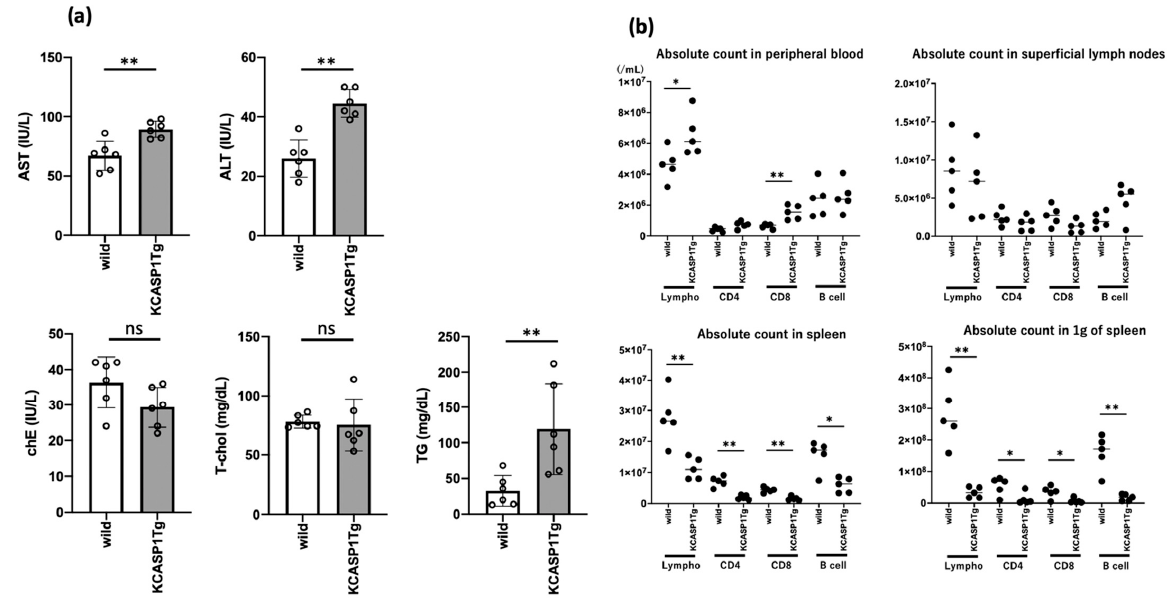
Figure 3. KCASP1Tg mice showed elevated serum liver transaminase and neutral fat level and insufficient production of lymphocytes. Plasma biochemical analysis and lymphocyte count in both 16-week-old KCASP1Tg and WT mice were performed (n = 6 per group). ( a ) The concentration of serum liver transaminase, neutral fat levels were elevated in KCASP1Tg mice with significance ( p values; AST, 0.0087; ALT, 0.0022; TG, 0.0087, respectively). ( b ) Peripheral blood lymphocyte count was elevated in KCASP1Tg mice compared to WT ( p = 0.0317). The amounts of CD8 were also increased in KCASP1Tg mice ( p = 0.0079). In superficial lymph nodes, the absolute number of lymphocytes, CD4 T cell, CD8 T cell, and B cell counts were unchanged. However, the counts of total lymphocyte, CD4, CD8, and CD20 in the whole spleen were decreased in KCASP1Tg mice. The counts per weight of spleen were also decreased in KCASP1Tg mice. Values are presented as mean ± SD, and statistically significant differences (* p < 0.05, ** p < 0.01) are indicated. (AST, aspartate aminotransferase; ALT, alanine aminotransferase; chE, cholinesterase; T-chol, total cholesterol; TG, triglyceride; ns, not